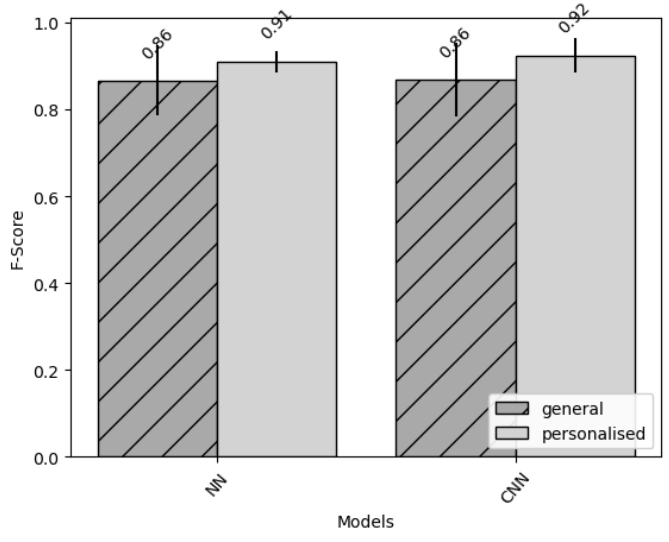
Figure 1. Comparison of the accuracy of general and personalised methods for both the NN and CNN